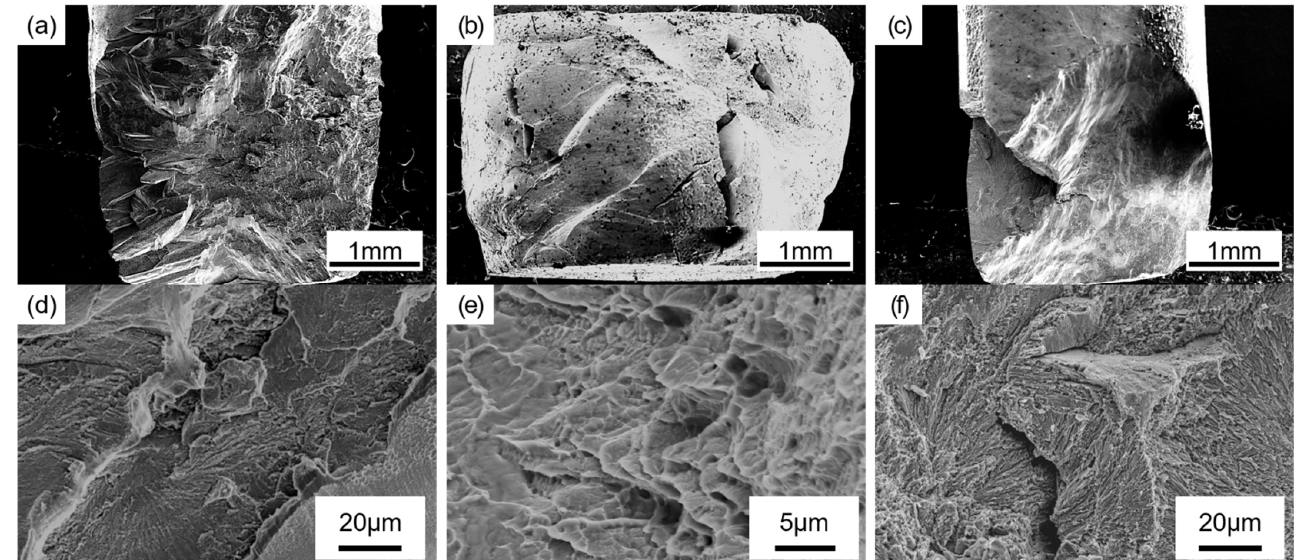
Figure 6. The SEM images of the samples after the compression test and the fracture surface of the Al 15 Zr 40 Ti 28 Nb 12 M 5 (Cr, Mo, Si) HEAs, ( a – c ) the compressed samples morphology of the Cr 5 , Mo 5 and Si 5 HEAs, respectively; ( d – f ) the fracture-surface image of the Cr 5 , Mo 5 and Si 5 HEAs, respectively.